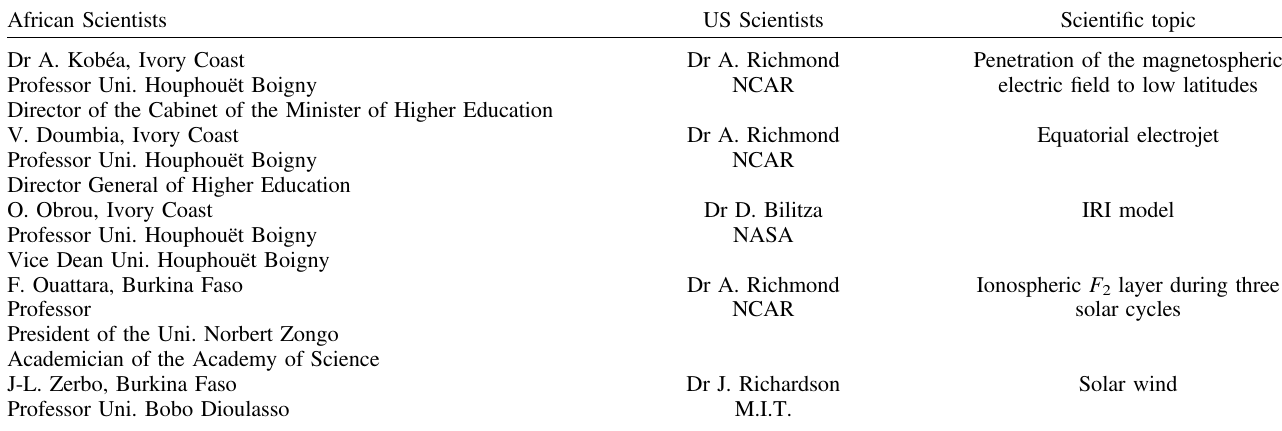
Table 1. Fulbright grants for scientist of the